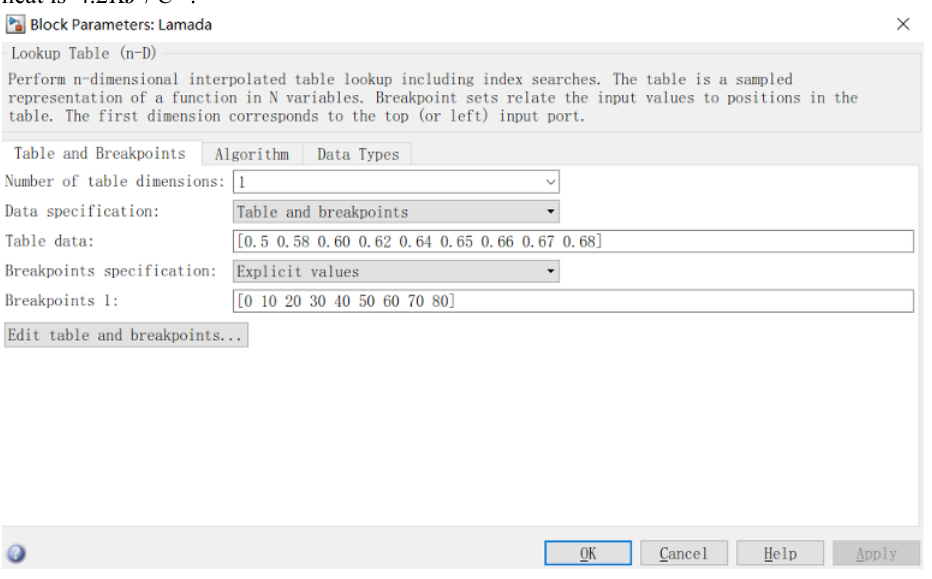
Fig. 5. Lamada parameter.